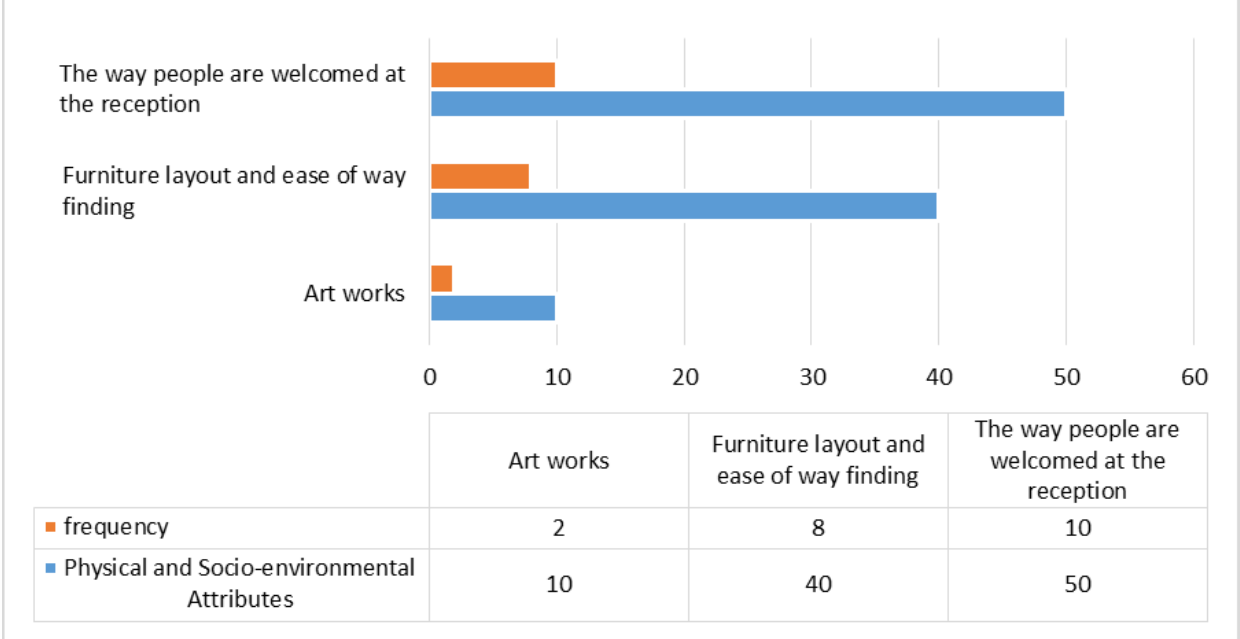
Figure 6. Attributes of supportive healing at EMU Health Centre. Table 2. Rating of supportive healing features present in EMU health centre Physical